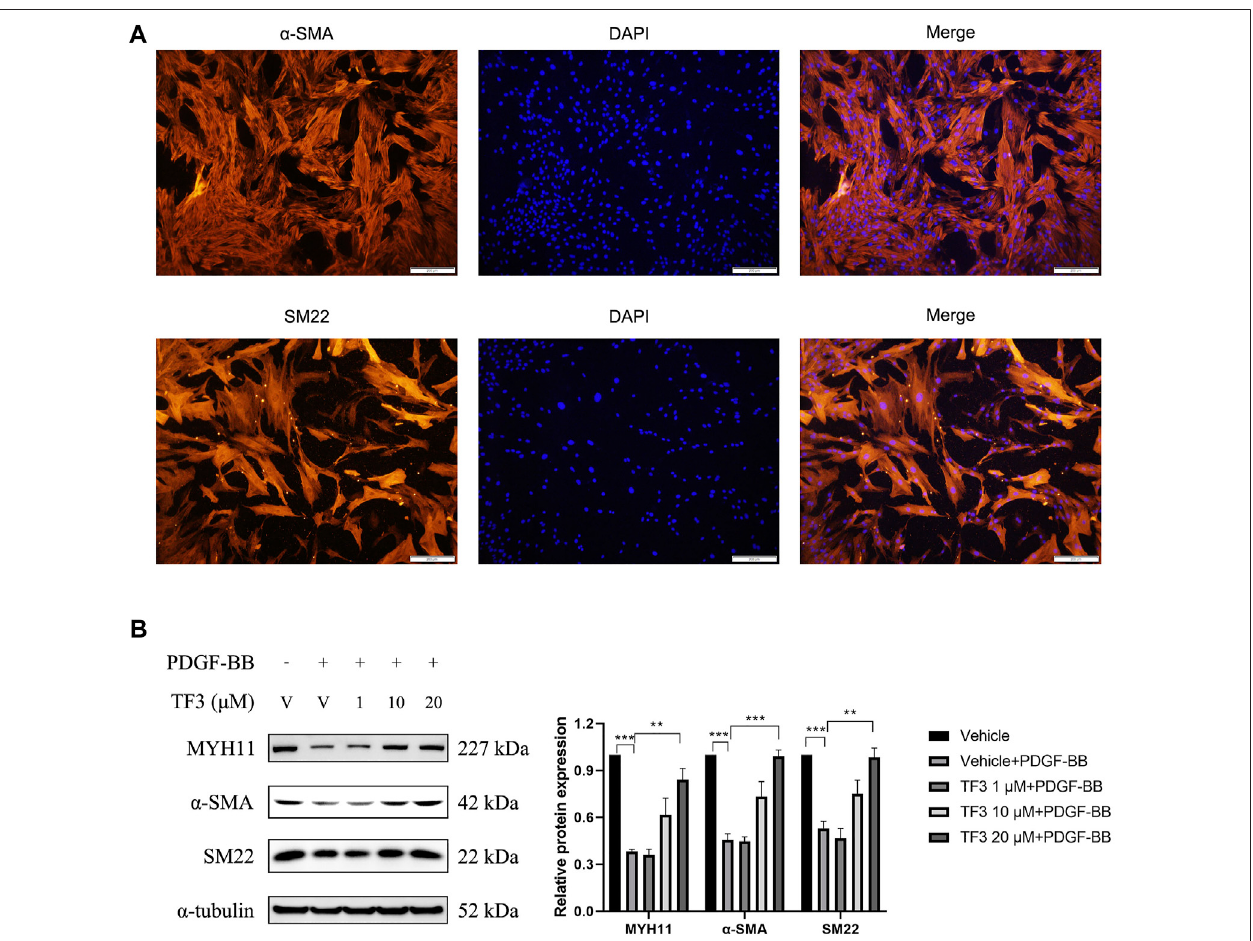
FIGURE 3 | Effects of thea fl avin-3,3 ′ -digallate (TF3) on PDGF-BB – induced phenotypic switching in RASMCs. (A) RASMCs were stained with α -SMA (red) and DAPI (blue). Scale bar, 200 μ m (B) The serum-starved RASMCs were pretreated with 1, 10, or 20- μ M TF3 for 1 h, and then, the cells were stimulated with 20 ng/ml PDGF-BB for 48 h. The levels of contractile proteins MYH11, α -SMA, and SM22 were detected using western blot. Each experiment was performed in triplicate. ** p < 0.01, *** p < 0.001.